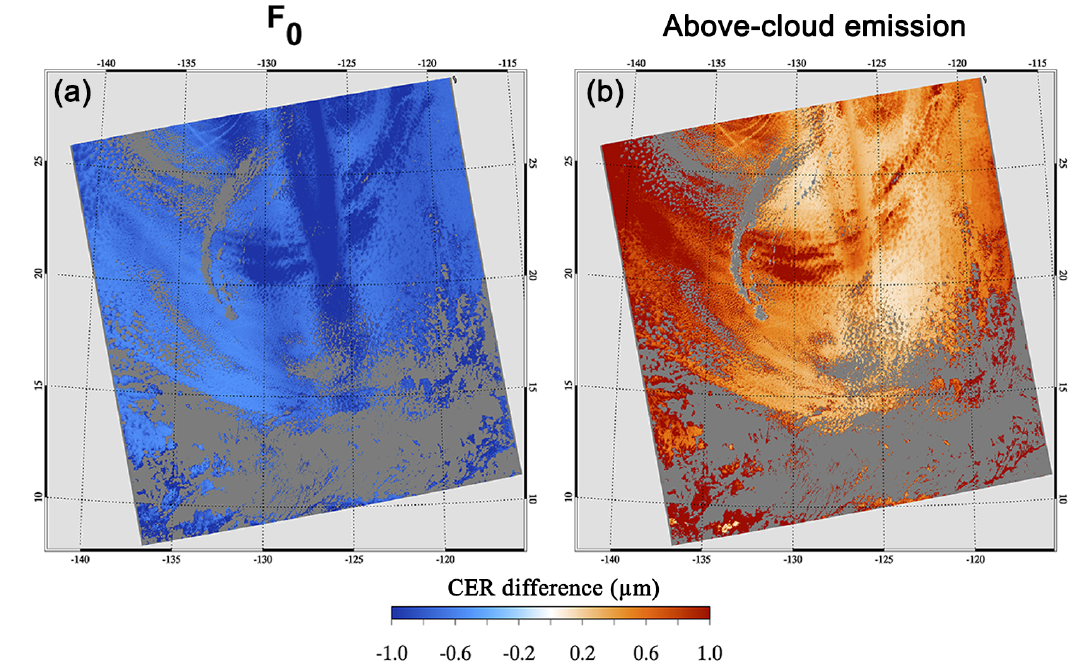
Figure 7. C6–C5.1 r e, 3 . 7 retrieval differences due to (a) the change of the assumed solar irradiance ( F 0 ) at 3.7µm and (b) correctly accounting for above-cloud atmospheric emission previously ignored in